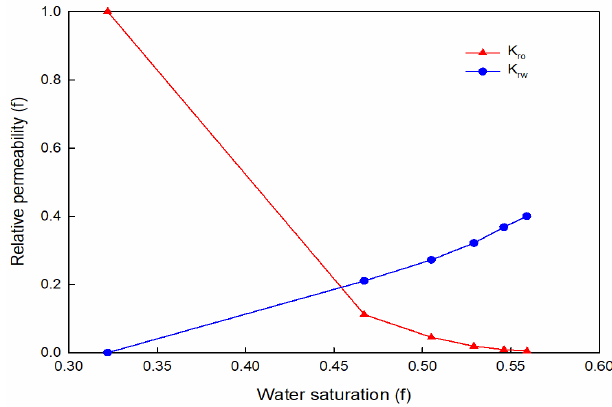
Figure 12. Relative permeability curve of WYQ.